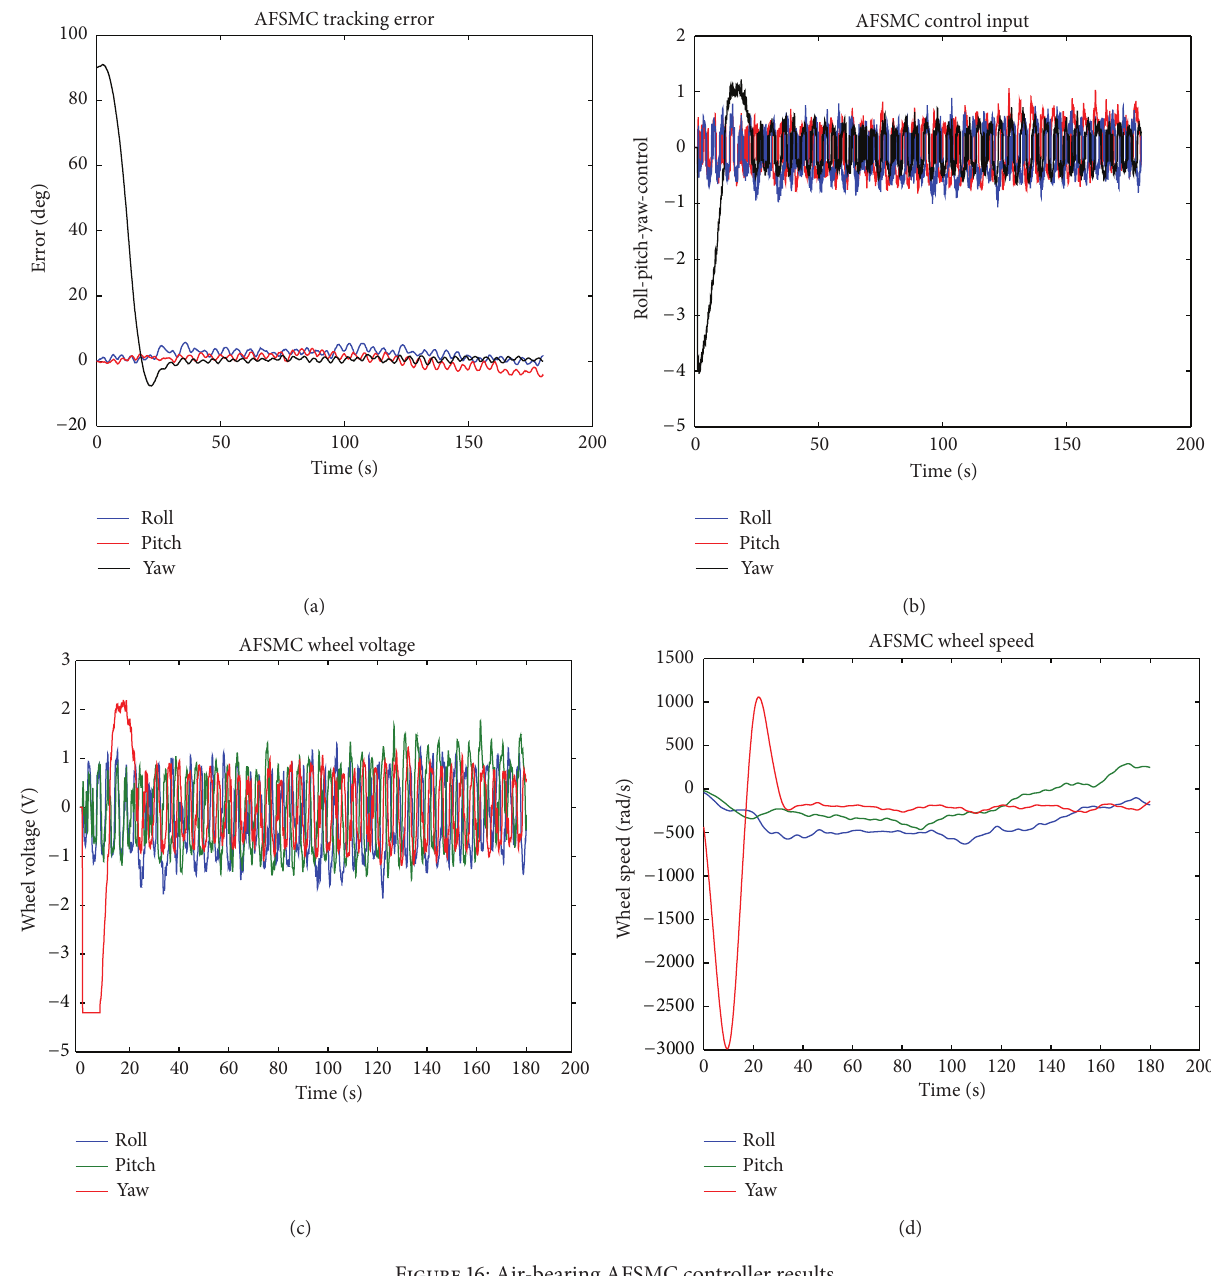
Figure 16: Air-bearing AFSMC controller results.